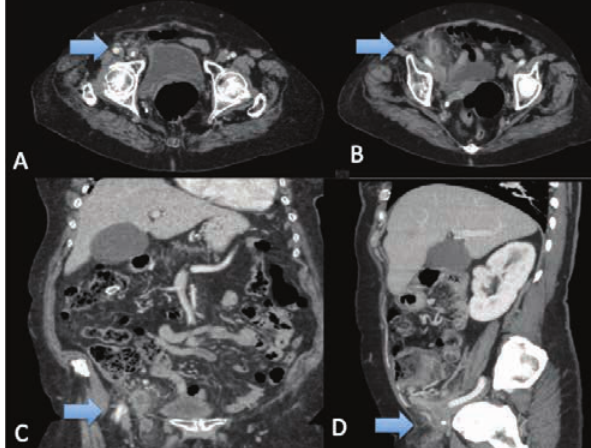
Figure 3: A,B,C,D Case Report 2. CT images Arrow: